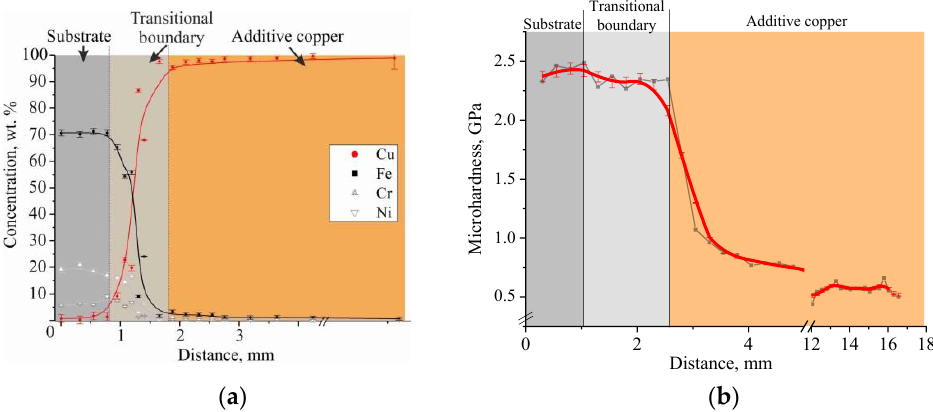
Figure 10. Changes in the elemental composition wt. % (SEM EDS analysis) ( a ) and dependence of the microhardness values ( b ) with the distance from the substrate of C-type copper